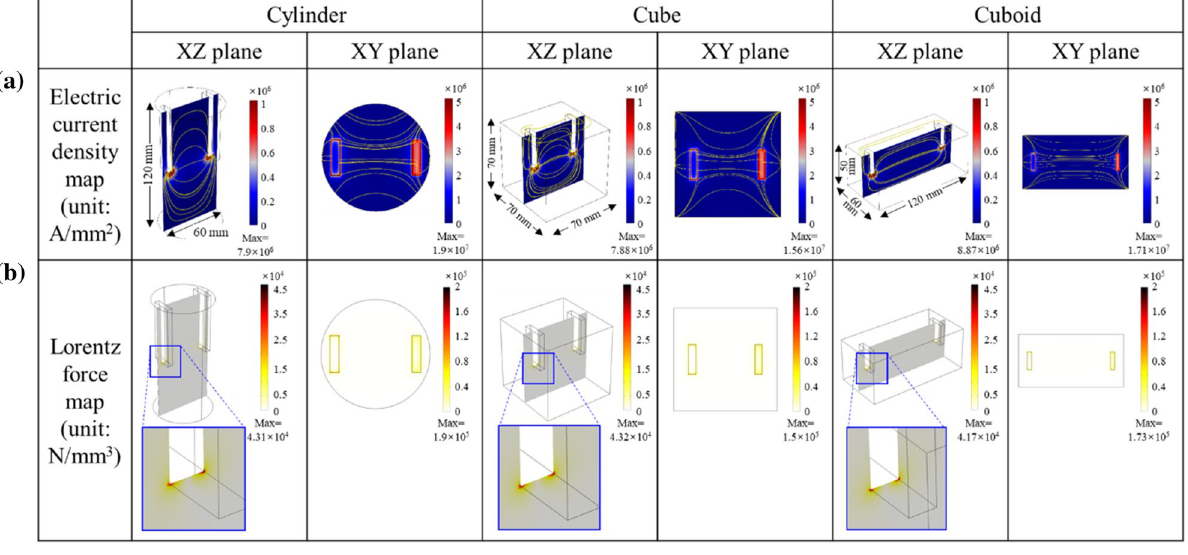
Figure 5. ( a ) Electric current density map and ( b ) Lorentz force map for the cylinder-, cube-, and cuboid- shaped cavities from the numerical